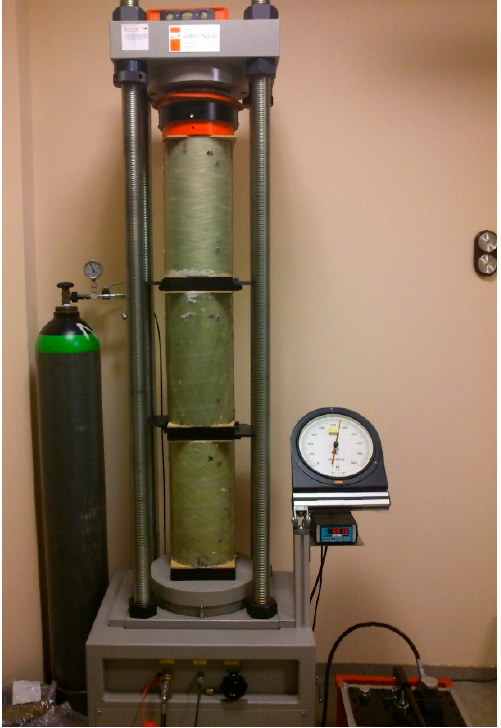
Figure 17. Testing of rheological deformations (creep and shrinkage).